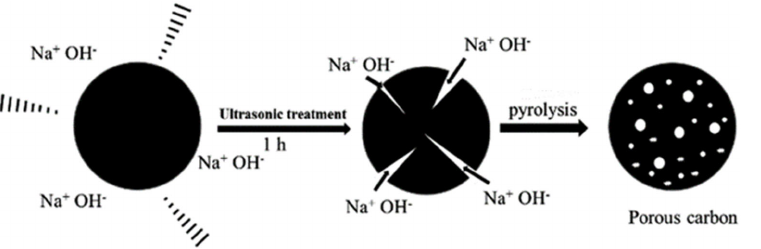
Figure 12. Representation of sono ‐ chemical method to produce surface modified porous carbon. Reprinted with permission from Ref. [219]. Copyright © The Royal Society of Chemistry 2020.